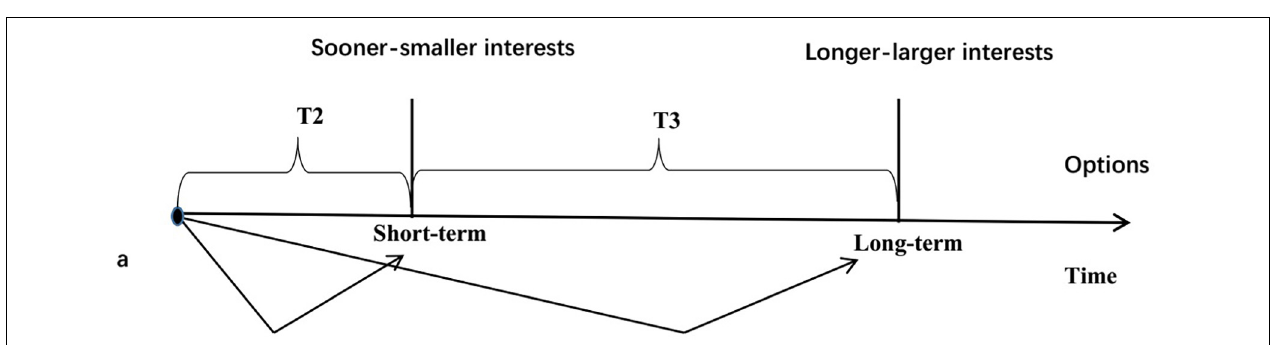
intertemporal decision-making. In contrast, under the condition of non-choice deferral behavior, consumers perceive a shorter time distance, which leads them to pay more attention to partial interests and the surface of things, so they choose the option with shorter-smaller interests (SS). Based on these facts, hypothesis H1 is